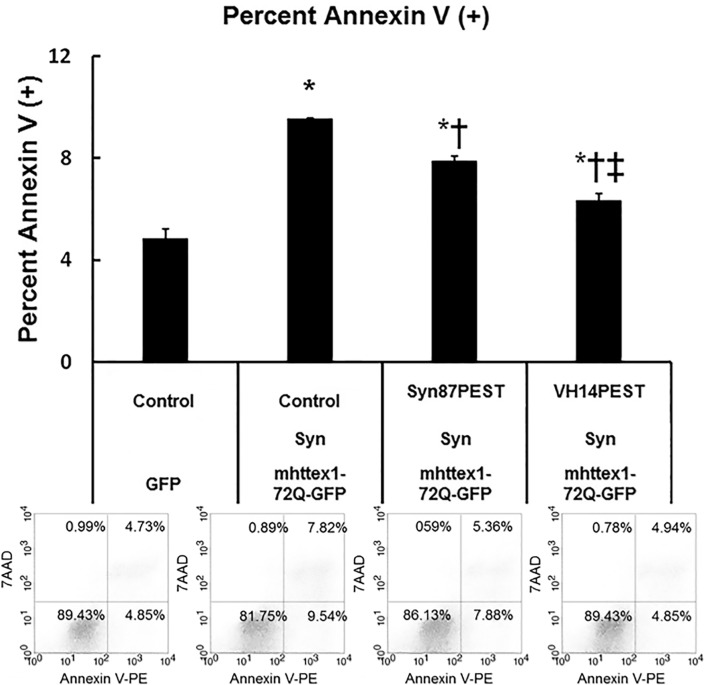
VH14PEST decreases the toxicity of α-Syn as measured by a proteostatic assay with mhttex1-72QGFP.VH14PEST reduced toxicity induced by proteostatic stress of co-expressing mhttex1-72Q-GFP with WT α-Syn overexpression. Overexpression of empty vector control plus mhttex1-72Q-GFP and WT Syn significantly increased early apoptotic cell death compared to empty vector GFP control [Mean ± SEM. *p<0.05 significantly different from all groups; n = 3]. VH14PEST significantly (‡p<0.05) reduced the percentage of apoptotic cell death to a greater extent than Syn87PEST [Mean ± SEM. *p<0.05 compared to Empty Vector control GFP; ‡p<0.05 comparing VH14PEST vs. Syn87PEST; †p<0.05 comparing Syn87PEST vs empty vector control-Syn-mhttex1-72Q-GFP.]. Lower Panel: Representative scatter plots showing the percentage of cells in each quadrant.